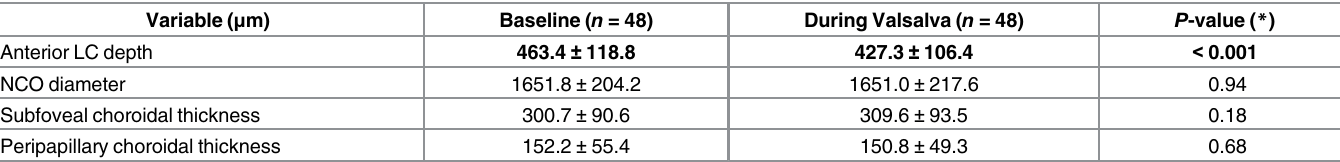
Table 3. Anterior lamina cribrosa depth, neural canal opening diameter, and choroidal thickness change during standardized Valsalva